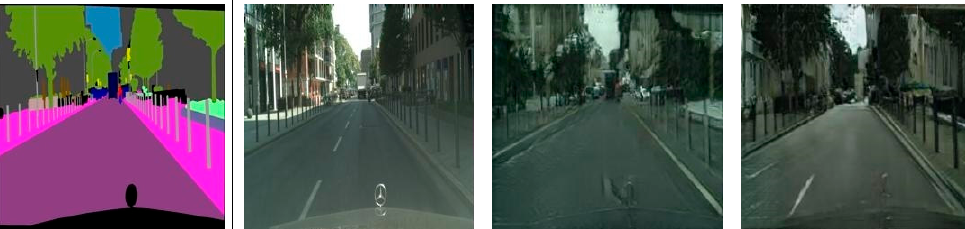
Figure 6. Translated pictures of CycleGAN and our method for the cityscapes dataset. From left to right: input, ground truth, Cycle-GAN (Baseline), and our method. The results of CycleGAN show unstable translations, including mistranslations between colonnade tree label and the building appearance. Our method helps to avoid these instabilities during the learning stage and produces more correct translation results.